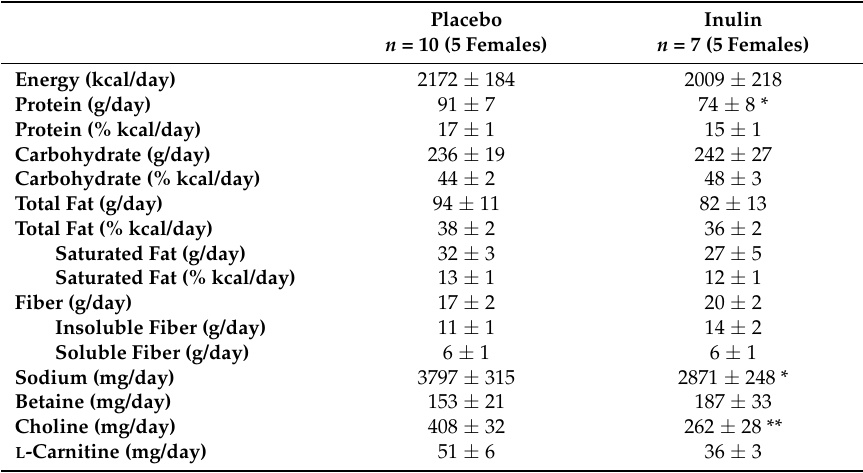
Table 3. Habitual dietary intake of inulin and placebo